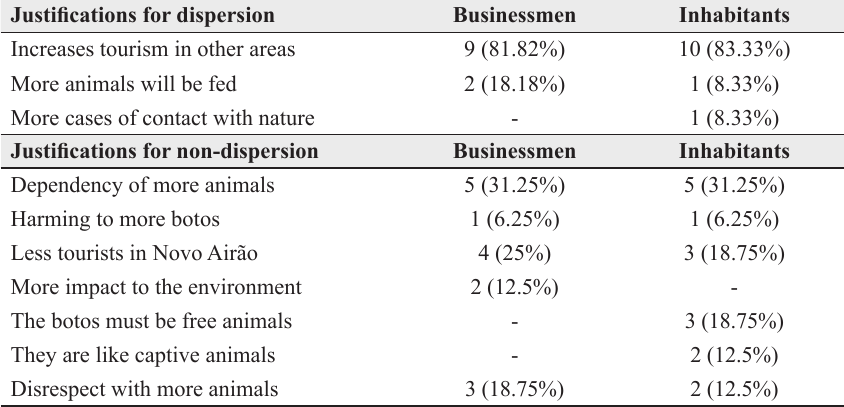
Justifications for the dispersion and the non-dispersion of the botos feeding tourism to other areas, accordingly to the businessmen and inhabitants of Novo